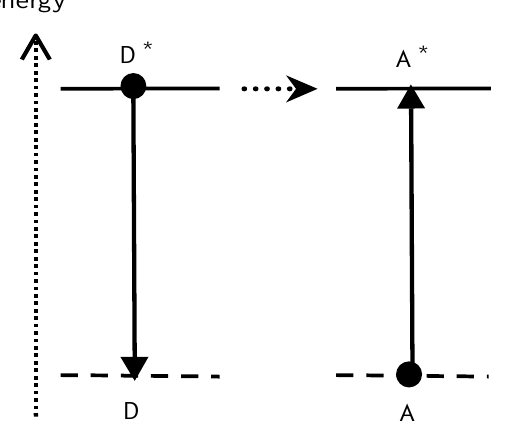
Fig. 4 . Energy transfer from donor D to acceptor A. In the case of an energy difference between the excited state of D and that of A, the transfer has to be assisted by a phonon. After